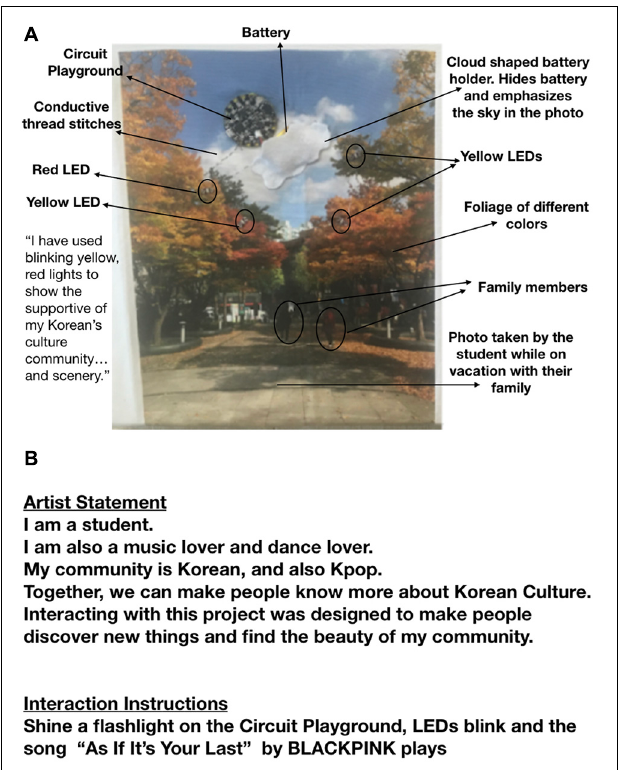
FIGURE 2 | Jae’s Conceal/Reveal Project, Artist Statement, and Interaction